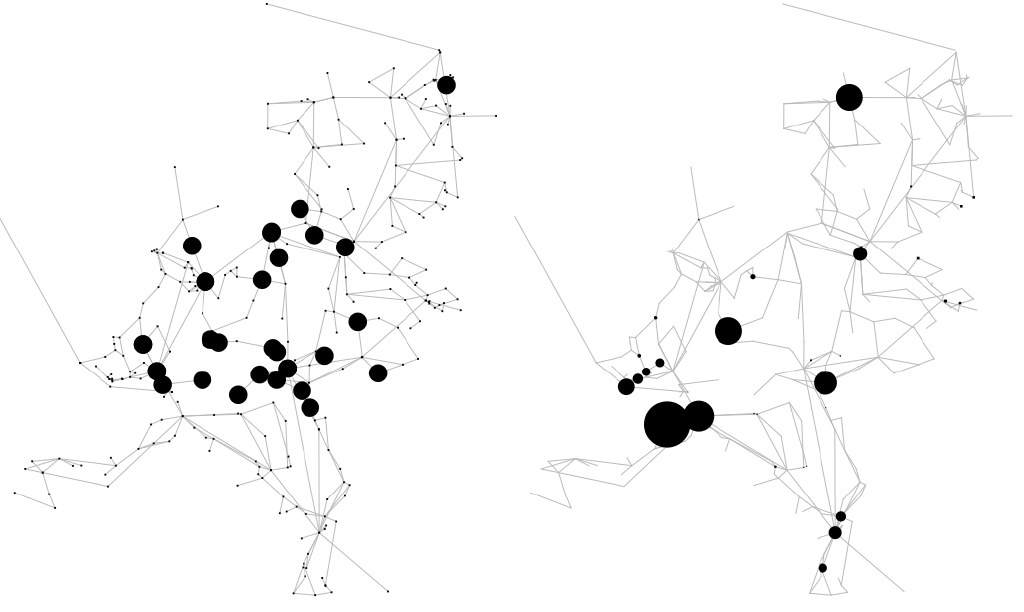
Figure 3. Vulnerability of technical components of the Dutch electricity infrastructure. The left pane shows the flood vulnerability of substations in the Netherlands, based on an assumed protection level of 2.5 meters. Large circles indicate substations with projected maximum flood heights exceeding their protection level. Small circles indicate substations with projected maximum flood heights below their protection level. The right pane shows the heat wave vulnerability of generators in the Netherlands. (Groups of) generators are represented by circles, which are sized according to the magnitude of their vulnerable capacity. Larger circles represent (groups of) generators with more vulnerable capacity. Generators are grouped according to the substation to which they are